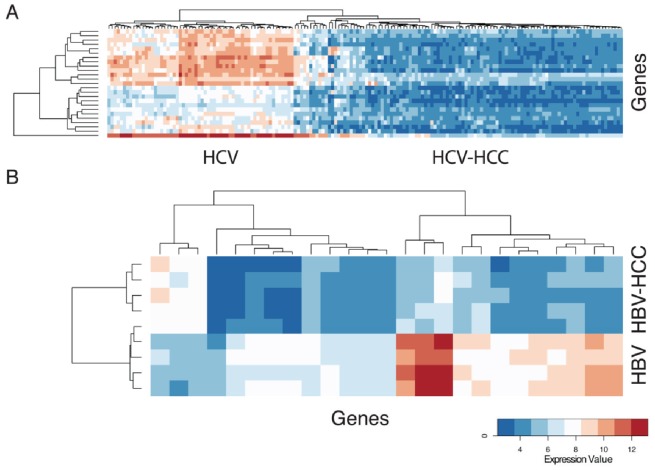
Gene expression profiles differentiate HCC from background liver cirrhosis.A) Heatmap of the 25 most significant genes with differential expression between HCV liver disease and HCV-related HCC. The gene names are listed in Table 3. B) Heatmap of the 25 most significant genes with differential expression between HBV liver disease and HBV-related HCC. The gene names are listed in Table 4.